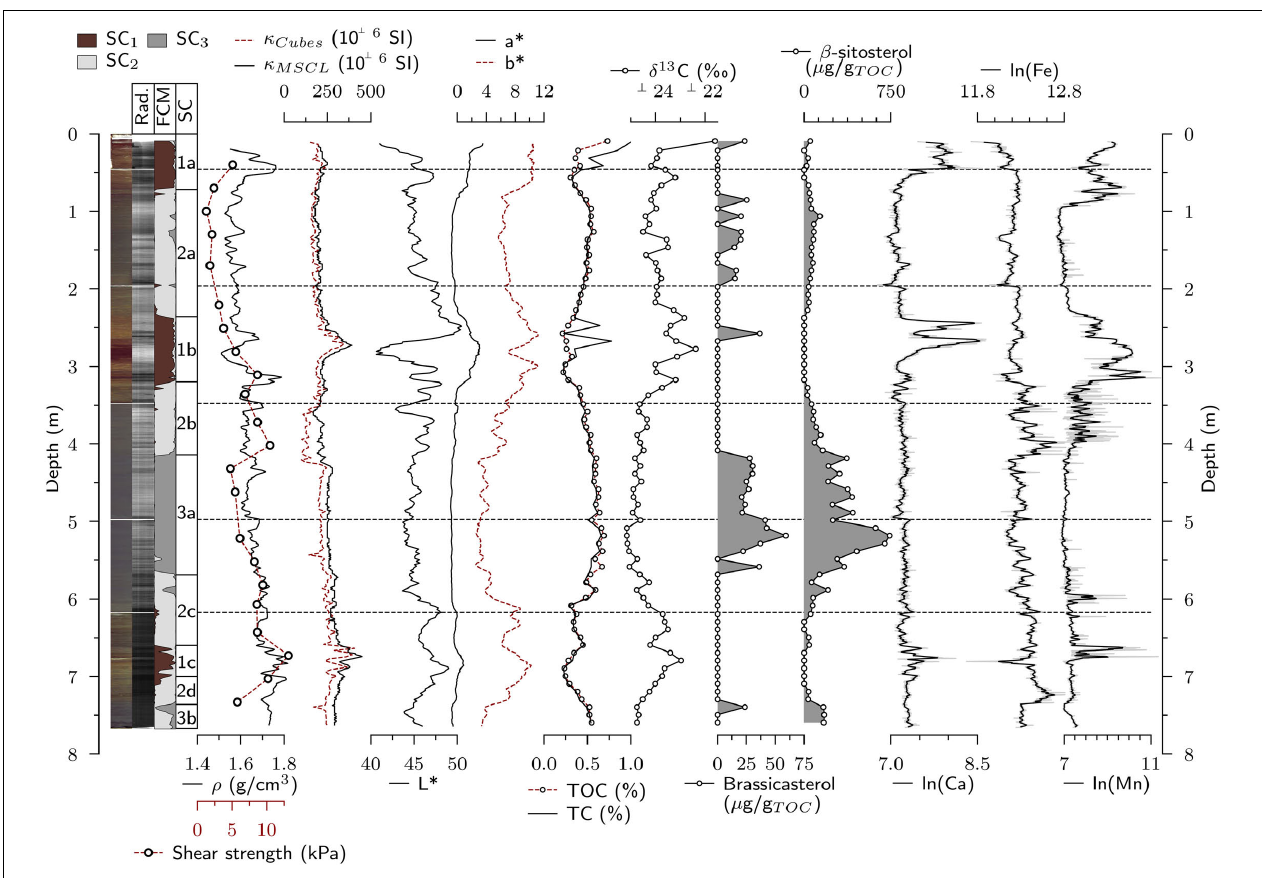
FIGURE 2 | Line-scan image, radiographs, FCM results and downcore variations of physical, chemical, carbon and biomarker data of core SWERUS-L2-13-PC1. From left to right: density ( ρ ; solid black line) and shear strength (red dashed line), volume magnetic susceptibility from multi sensor core logger loop sensor (solid black line) and palaeomagnetic cubes (red dashed line), colour lightness (L), green-red (a*; solid black line) and blue-yellow (b*; red dashed line) colour components, total carbon (TC; solid black line) and total organic carbon (TOC; red dashed line), stable carbon isotopes ( δ 13 C), (marine) organic sterol concentration (brassicasterol), (terrigenous) organic sterol concentration ( β -sitosterol), relative calcium (Ca) content, relative iron (Fe) content and relative manganese (Mn) content. FCM is based on all displayed parameters except shear strength, κ MSCL and TC. Elemental data are scatter and log